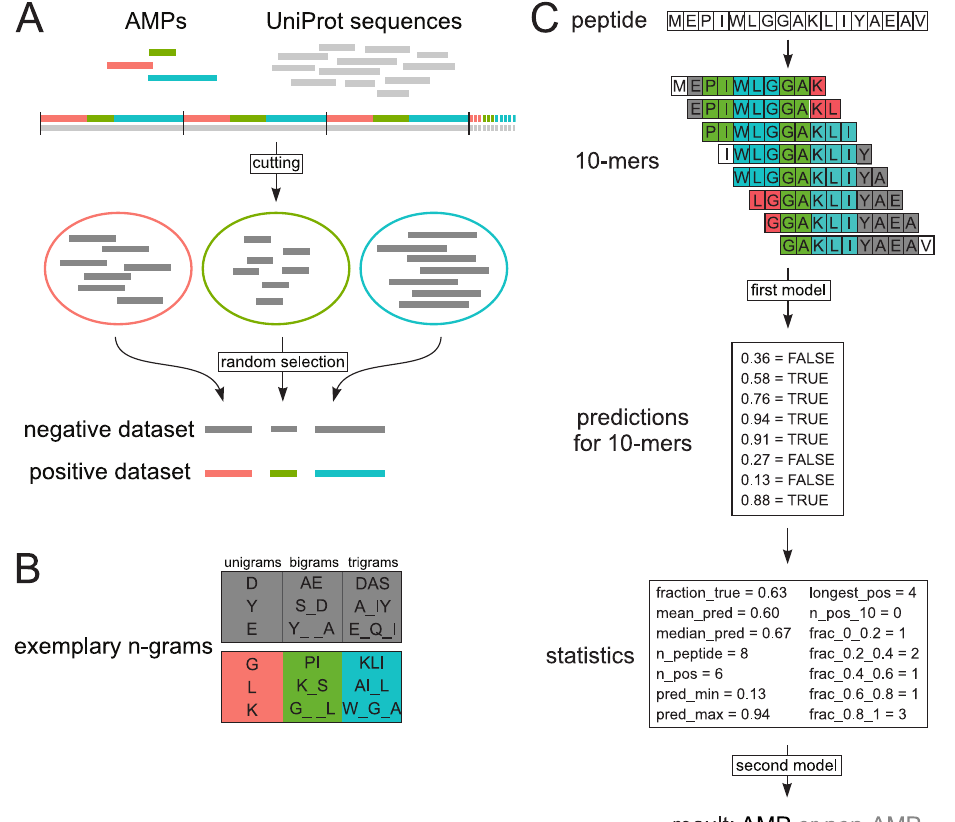
Figure 4. Schematic representation of datasets preparation ( A ), n-grams ( B ) and decision-making procedure in AmpGram ( C ). The positive dataset was constructed from sequences downloaded from the dbAMP database [39] (red, green and blue horizontal lines). To create the negative dataset, non-antimicrobial sequences (grey horizontal lines) were retrieved from the UniProt database [38]. The sequences were first concatenated into one string (grey horizontal line), and then cut (black vertical lines) into blocks corresponding in length to sequences from the positive dataset (red, green and blue horizontal line). The extracted blocks were next cut (not indicated in the figure) into subsets corresponding in length to sequences from the positive dataset (red, green and blue circles) and from them individual sequences were randomly selected for the negative dataset ( A ). Exemplary n-grams used to train AmpGram: the positive n-grams are shaded in red, green and blue, and the negative ones in grey ( B ). To make a prediction, AmpGram first divides a peptide into subsequences of 10 amino acids (10-mers). For each 10-mer, AmpGram makes a prediction if it is an AMP (true) or not (false) (first model). To scale the prediction for 10-mers to the whole peptide, a lot of statistics is calculated and on their basis AmpGram makes the final prediction (second model). Abbreviations of the statistics: fraction_true--fraction of positive 10-mers, pred_mean–mean value of prediction, pred_median–median of prediction, n_peptide - number of 10-mers in a peptide, n_pos–number of positive 10-mers, pred_min–minimum value of prediction, pred_max–maximum value of prediction, longest_pos–the longest stretch of consecutively occurring 10-mers predicted as positive, n_pos_10–number of streches comprising of at least 10 10-mers predicted as positive, frac_0_0.2--fraction of 10-mers with prediction in range [0, 0.2], frac_0.2_0.4–fraction of 10-mers with prediction in range (0.2, 0.4], frac_0.4_0.6–fraction of 10-mers with prediction in range (0.4, 0.6], frac_0.6_0.8–fraction of 10-mers with prediction in range (0.6, 0.8], frac_0.8_1–fraction of 10-mers with prediction in range (0.8, 1]) ( C